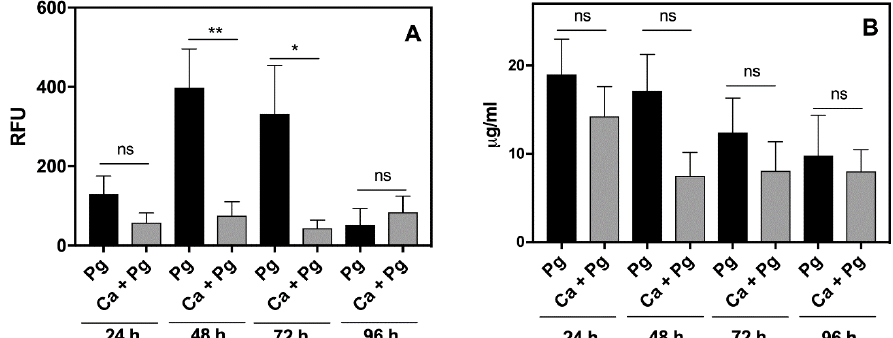
Figure 4. Activities of ( A ) the neutrophil enzymes elastase and ( B ) myeloperoxidase in the chamber fluid. Neutrophil elastase (NE) activity was measured in chamber exudates at selected time points using an EnzChek elastase assay kit. The appearance of the product was detected fluorometrically. Myeloperoxidase (MPO) activity was determined using its peroxidase properties and EnzChek MPO activity assay kit. Data are representative of two independent experiments and are expressed as means ± SEM. Significance was calculated using an unpaired t -test. Asterisks denote statistical significance ( p > 0.1234 ns, * p ≤ 0.0332, ** p ≤